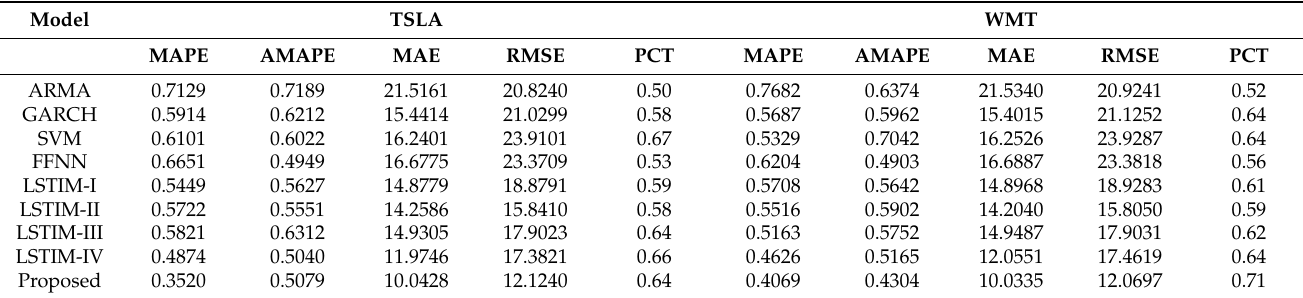
Table 7. Prediction performance for 75 days: TSLA and WMT.